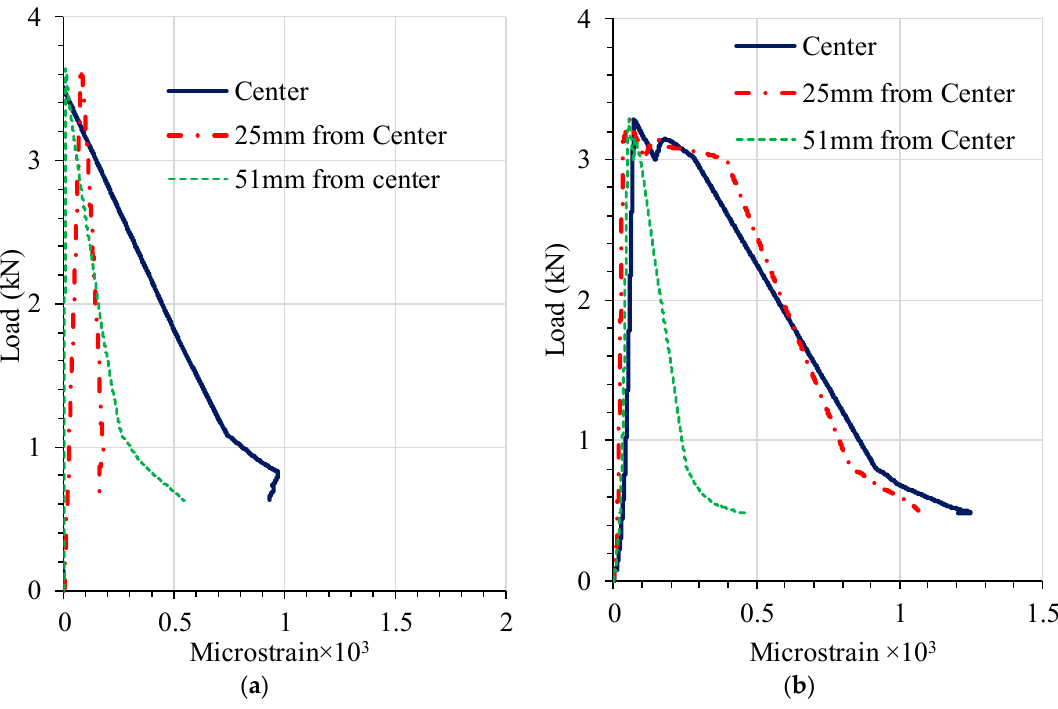
Figure 8. Strain developed in geogrids at various locations from center: ( a ) geogrid-reinforced specimen 1; ( b ) geogrid-reinforced specimen 2.